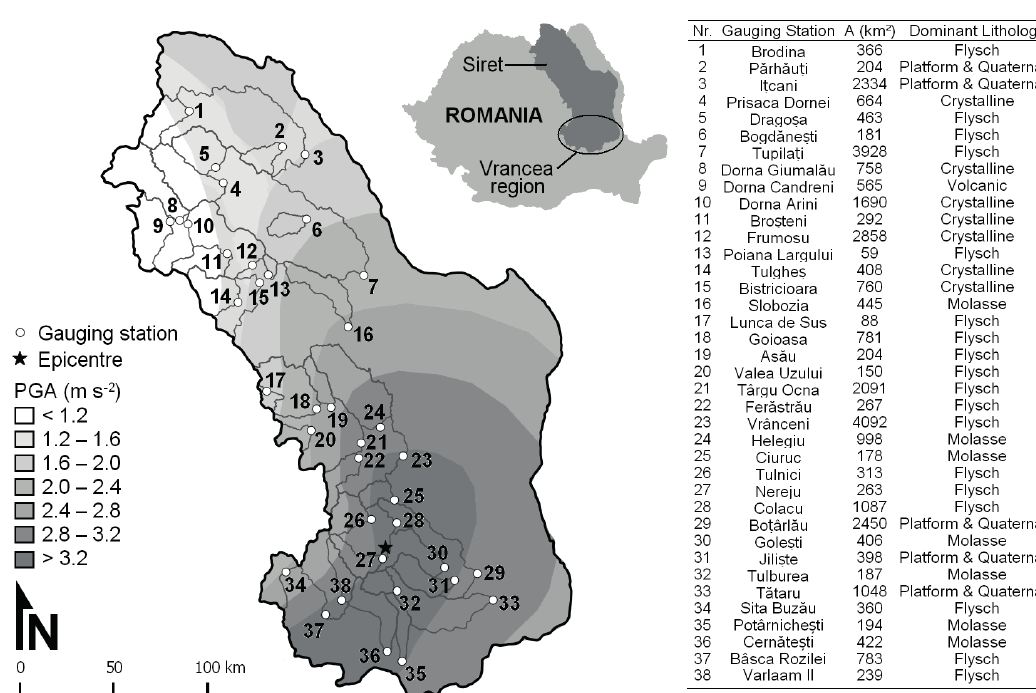
Fig. 1 Map of the Siret basin, the 38 subcatchments considered in this study and the epicentre of the M w 7.4 earthquake of 1977. ‘PGA’ indicates the expected Peak Ground Acceleration with a recurrence interval of 100 years (Lungu et al. , 2004). ‘A’ indicates the contributing area of each